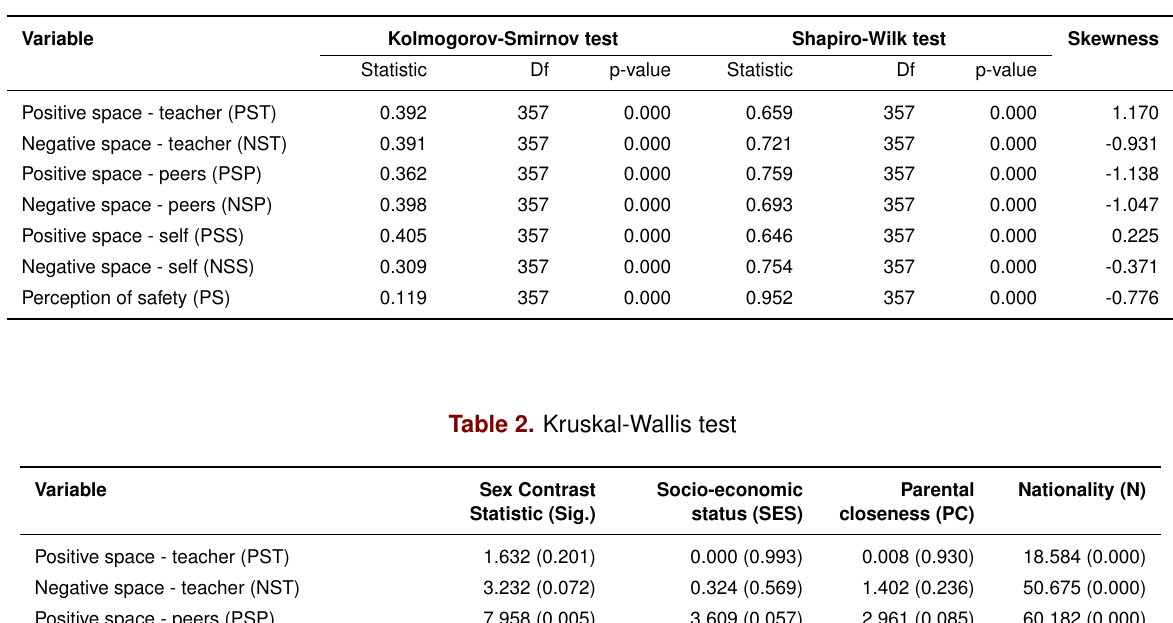
Table 1. Kolmogorov-Smirnov and Shapiro-Wilk test